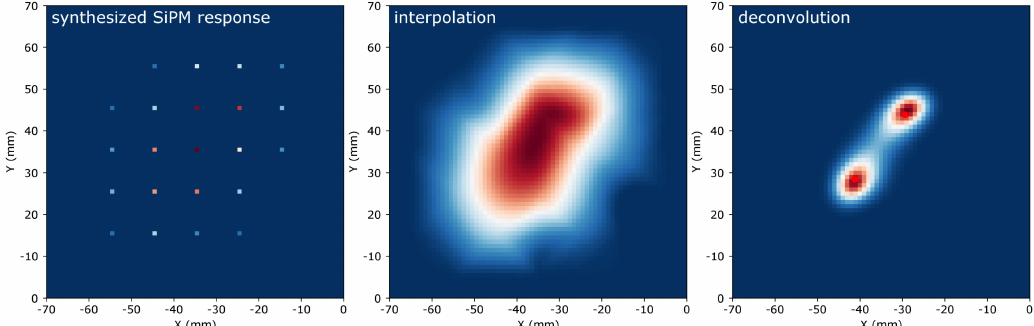
Figure 6 . Reconstructed pair of nearby 83 m Kr events from detector data, synthesized by overlaying SiPM response maps for two nearby events. Left column - raw (synthesized) SiPM data; center - bicubic interpolation; right - deconvolved image after 75 iterations. Red dots represent the COGs of individual